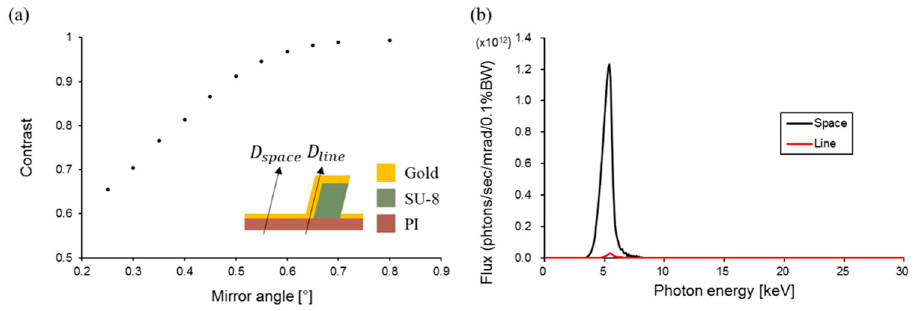
Figure 4. ( a ) Contrast according to the mirror angle (Arrows are dose on space ( 𝐷 (cid:3046)(cid:3043)(cid:3028)(cid:3030)(cid:3032) ) and dose on line ( 𝐷 (cid:3039)(cid:3036)(cid:3041)(cid:3032) )) and ( b ) spectra difference from the mirror set 0.6° between the line and the